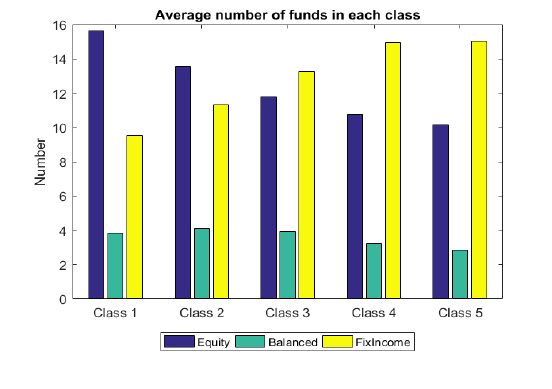
Figure 5. Mean Number of Mutual Funds Separated by Fund Type in Each